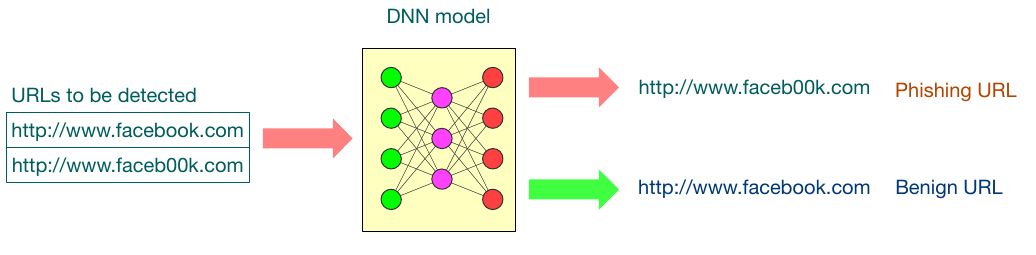
Figure 6. Deep-learning-based malicious website